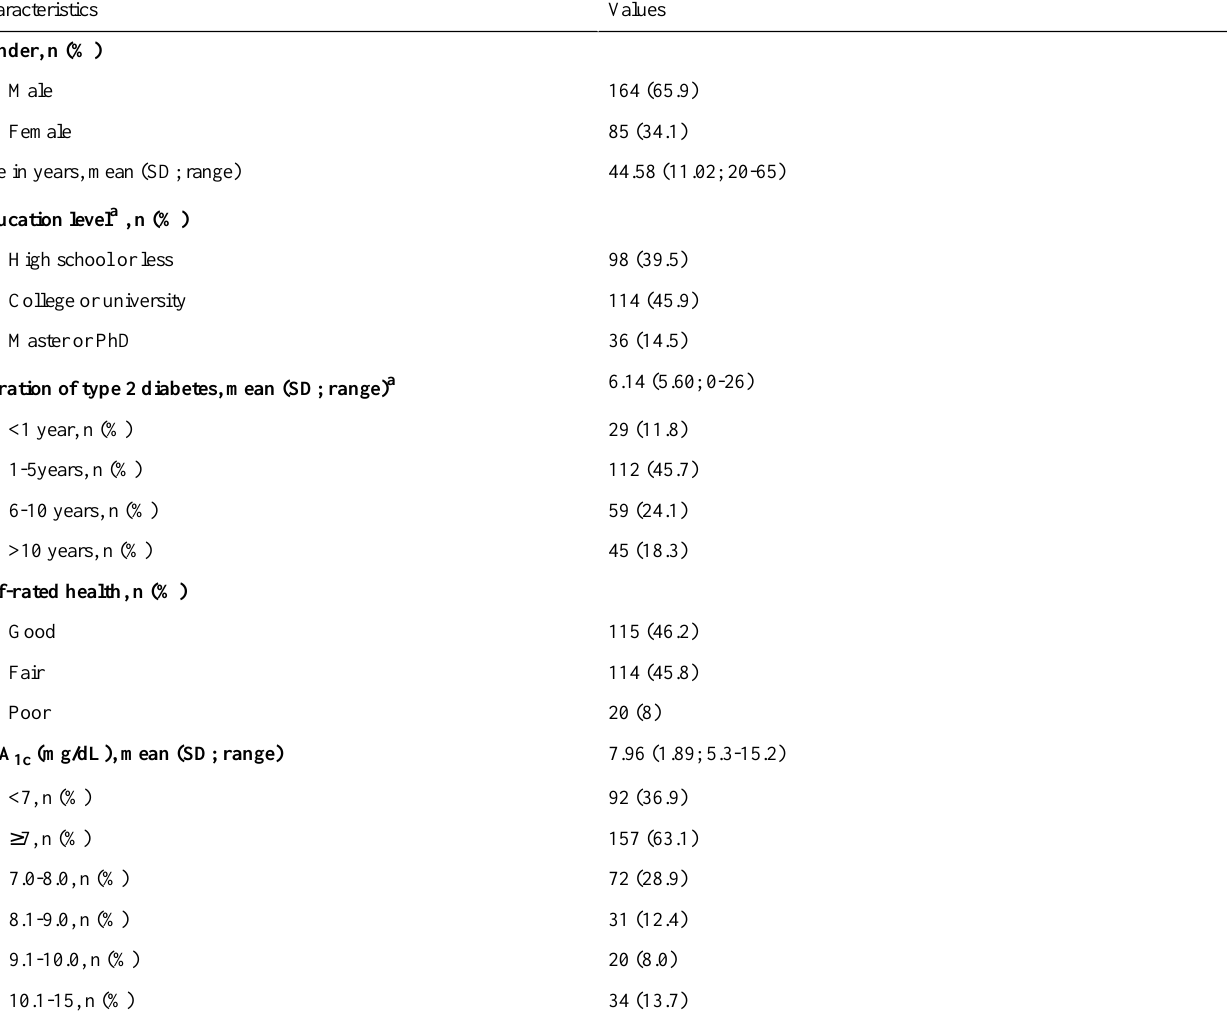
Table 1. Sociodemographic characteristics of the study participants (n=249).